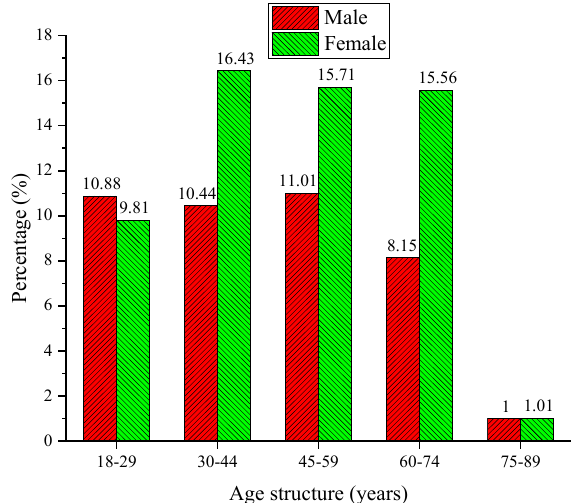
Figure 1. Gender and age composition of residents.